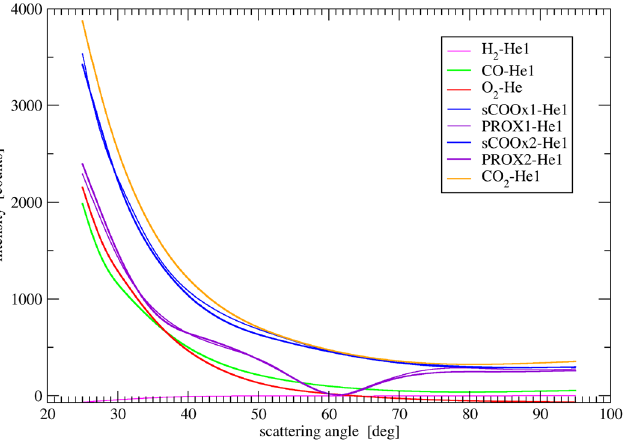
Figure 5. Background difference of the catalyst DPs measured at several gases and of the initial pattern in He. All patterns in He overlap with good accuracy.